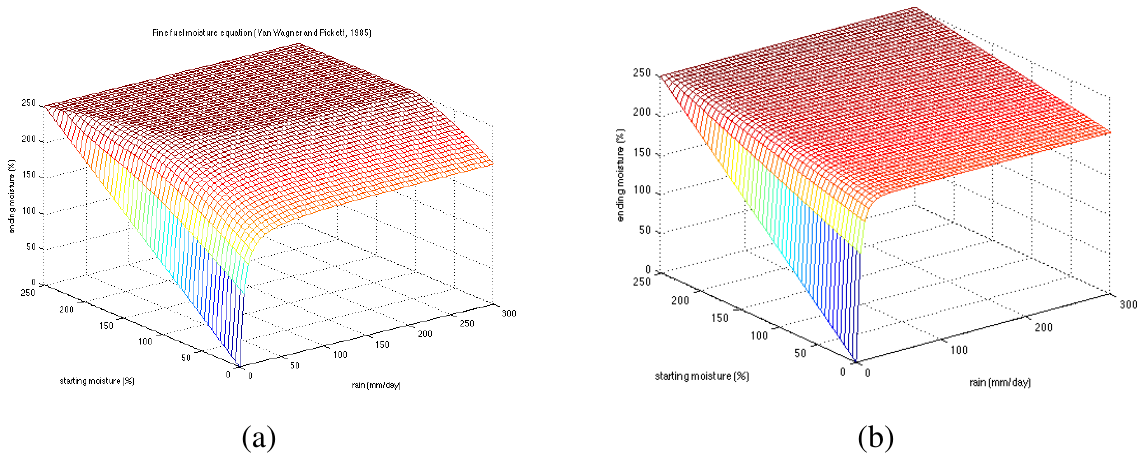
Figure 7. Response of fine fuels to rain over 24h (a) following Van Wagner and Pickett (1985) (b) from the time-lag model (Eq. 4) by a calibration of Fig. 6. Response of fine fuels to rain over 24 hours (a) following Van Wagner and Pickett (1985) (b) from the time-lag model (4) by a calibration of coefficients.